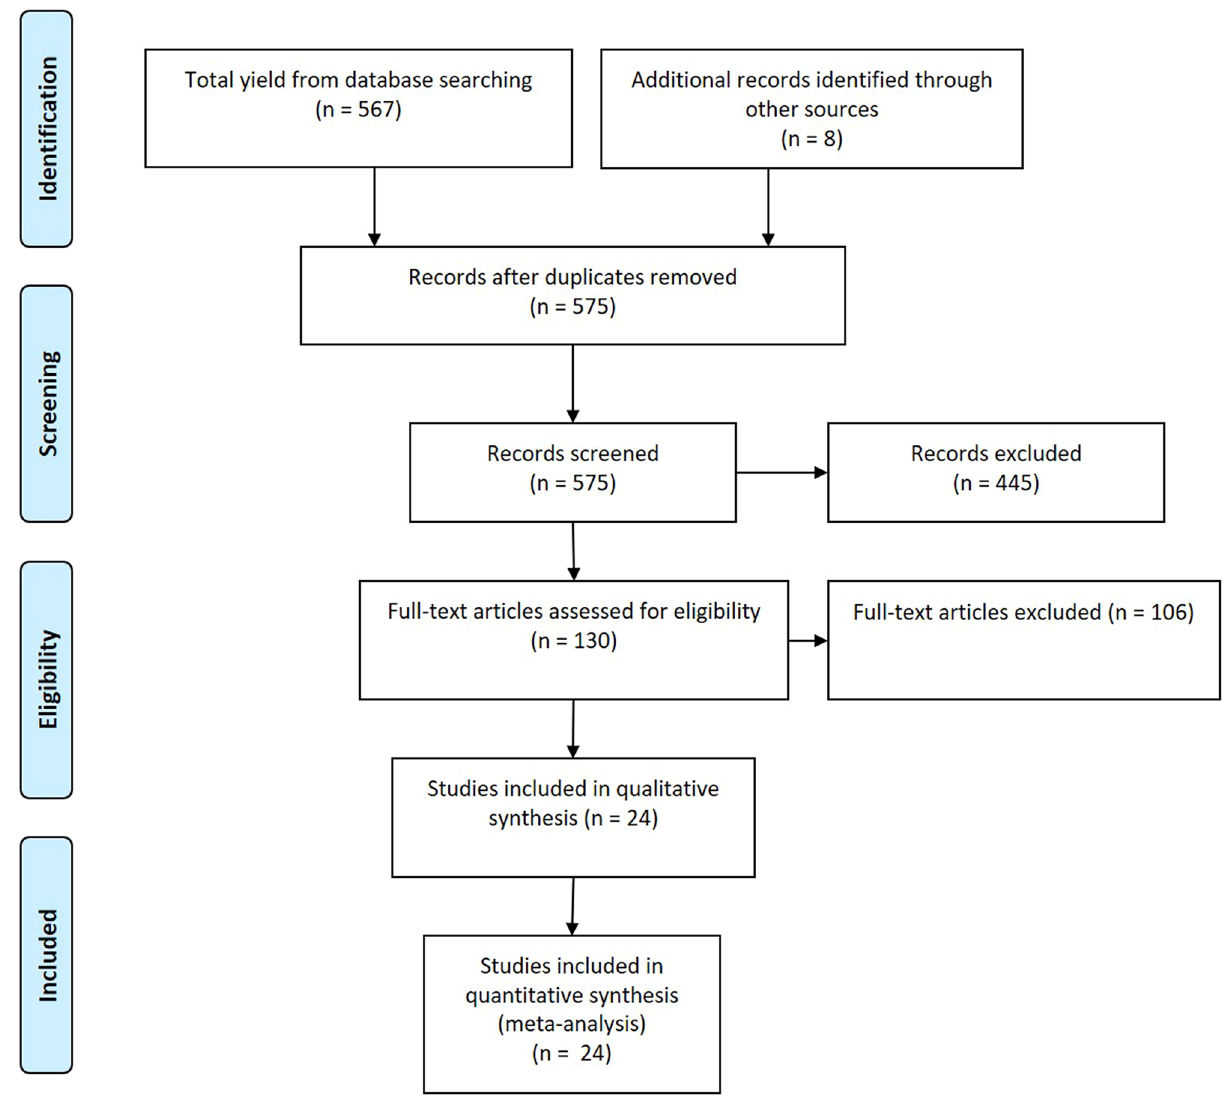
Figure 1. Study selection process. Our initial search of databases yielded 575 records. We searched the reference lists of relevant studies and related systematic reviews and found no additional records. After 445 records were excluded, 130 full-text articles were appraised. Thirty-eight were included in the qualitative synthesis and twenty-four were included in the quantitative analysis and meta-analyses. (CINAHL, Cumulative Index to Nursing and Allied Health Literature). Adapted from Moher et al. 65